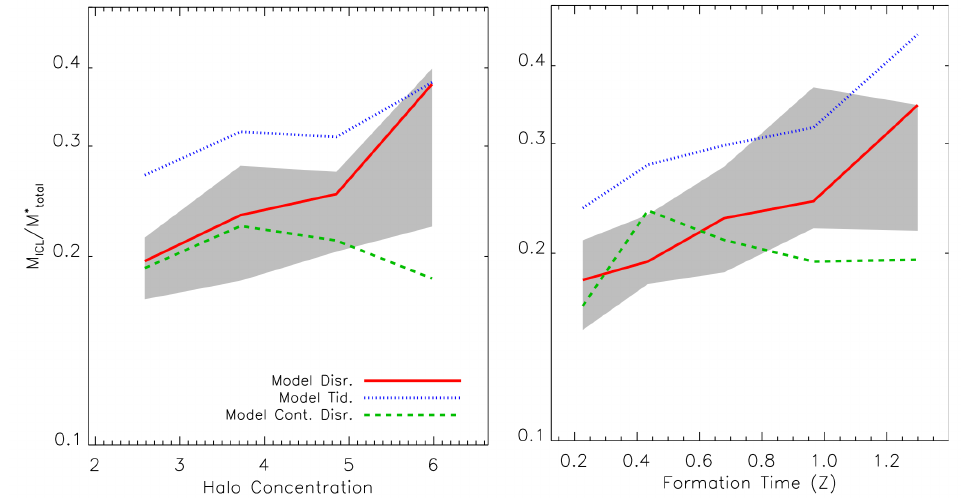
Figure 8. Left panel: fraction of ICL as a function of the concentration (defined as the ratio between the scale radius by assuming an NFW profile and the virial radius R 200 ) of 53 haloes with mass M 200 [ M (cid:12) / h ] > 10 14 . Right panel: same information but as a function of the halo formation time, defined as the time the first main progenitor acquired half of its final mass. The gray shaded regions show the 20th and 80th percentiles of the distributions. Credit: Contini et al.